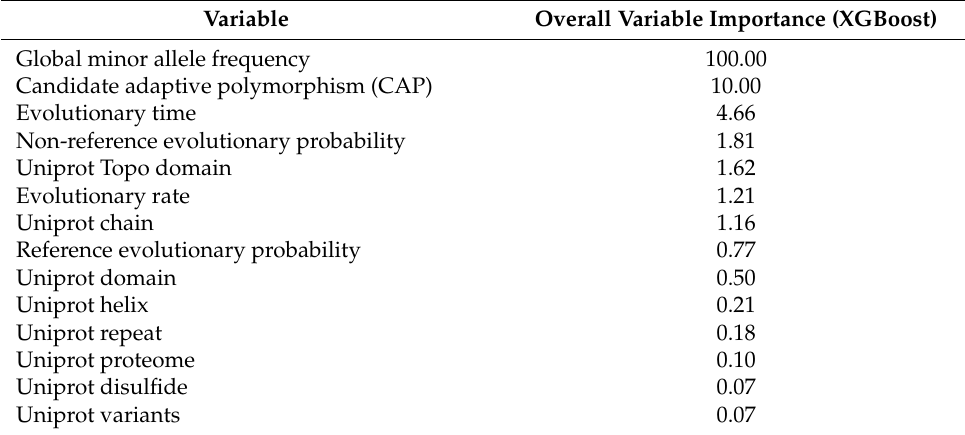
Table 4. Overall variable importance for